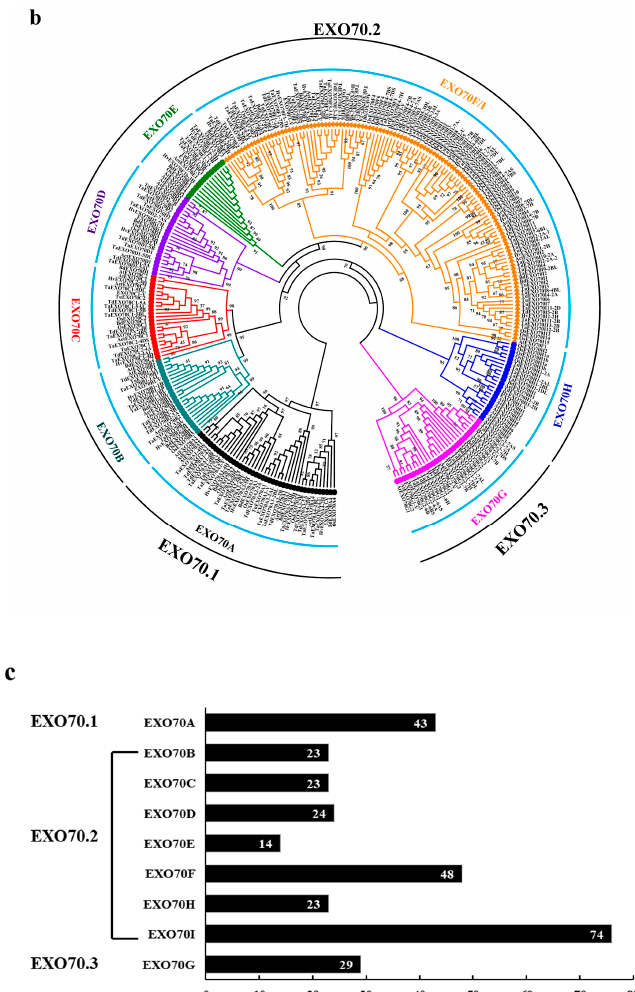
Figure 1. The number and phylogenetic relationships of EXO70 family genes from T. aestivum , T. urartu , Ae. tauschii , T. dicoccoides , H. vulgare , A. thaliana , Oryza sativa , Brachypodium distachyon and H. villosa . ( a ) The total number of EXO70 gene family in nine species. ( b ) The phylogenetic tree of nine Triticeae species. Species abbreviations: Ta, Triticum aestivum ; Tu, Triticum urartu ; Aet, Aegilops tauschii ; Td, Triticum dicoccoides ; Hv, Hordeum vulgare ; At, Arabidopsis thaliana ; Bd, Brachypodium distachyon ; Os, Oryza sativa ; -V, Haynaldia villosa . ( c ) The number of the EXO70 gene family from nine species in each of the subgroups. The horizontal/longitudinal coordinate axis represents the number of genes and different subgroups, respectively.